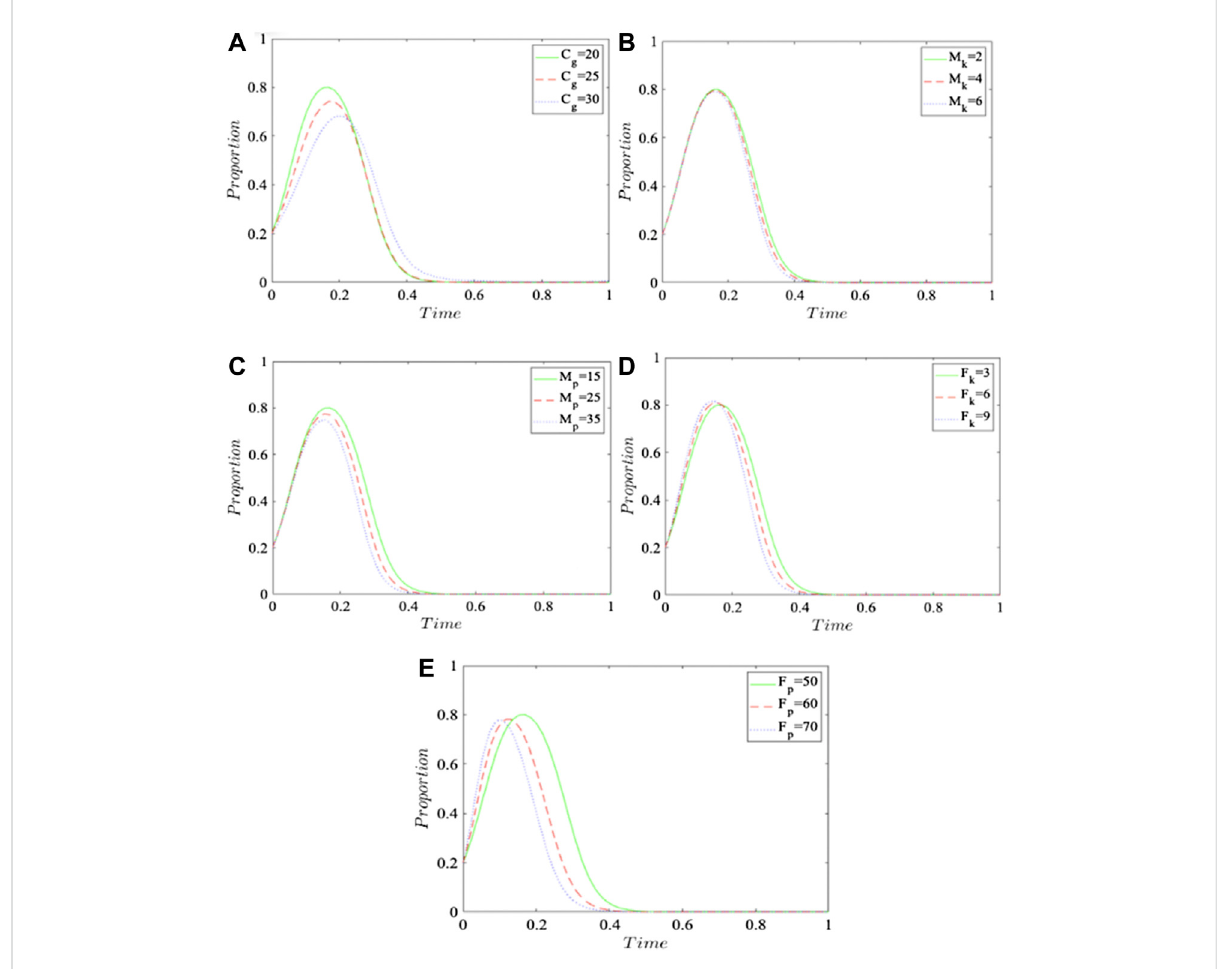
FIGURE 9 In fl uenceofchangingparametersonthegovernment. (A) Impactofchangesinmonitoringcosts, (B) impactofchangesinrewardsforrecycling enterprises, (C) impact of changes in rewards for power battery manufacturers, (D) impact of changes in punishments for recycling enterprises, (E) impact of changes in punishments for power battery